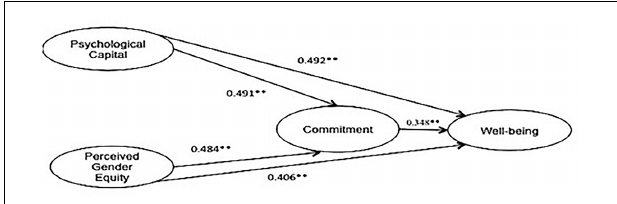
FIGURE 2 | Path model for PsyCap and PGE mediation of commitment in employee well-being. The path model is for full sample. Fit indices for the